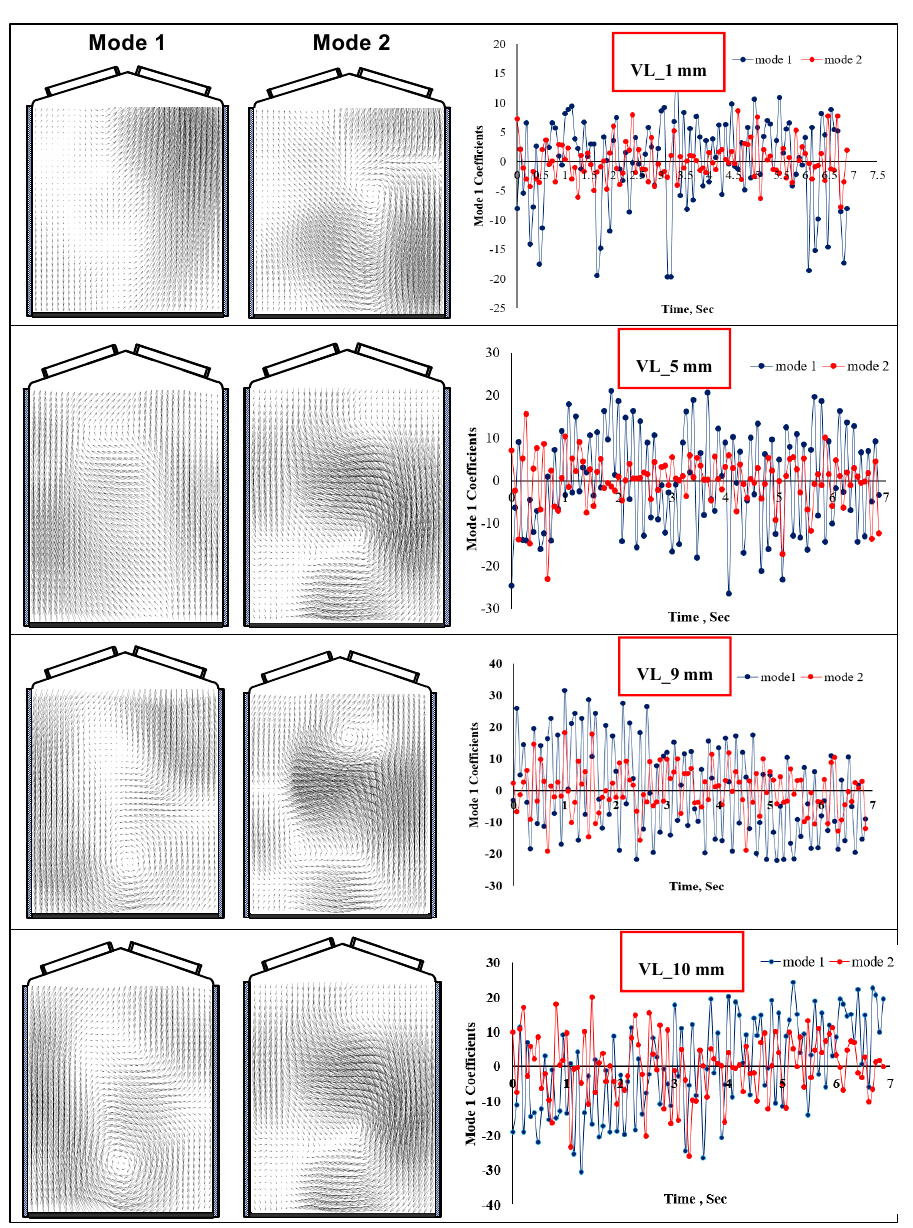
Figure 10. Mode 1 and mode 2 structures and their corresponding coefficients at different valve lifts. The reconstruction of the original velocity fields was performed for valve lifts 9mm and 10mm using the first five dominant modes, as shown in Figure 11. The reason for selecting only the first five modes was the fact that they contained 76.5% and 74.4% of the total energy for valve lift 9mm and 10mm, respectively. The reconstructed flow field for valve lift 9 mm successfully identified a dominant coherent structure at the bottom of the cylinder and a pair of clockwise and counterclockwise rotating coherent structures in the upper half of the cylinder. All these flow patterns were in full agreement with the ensemble average field. The reconstruction of the velocity field for valve lift 10 mm also identified the same flow features, as witnessed in the ensemble average velocity field. It was concluded that the first five modes were sufficient for the reconstruction of the flow field, which also provided validation for the POD results.